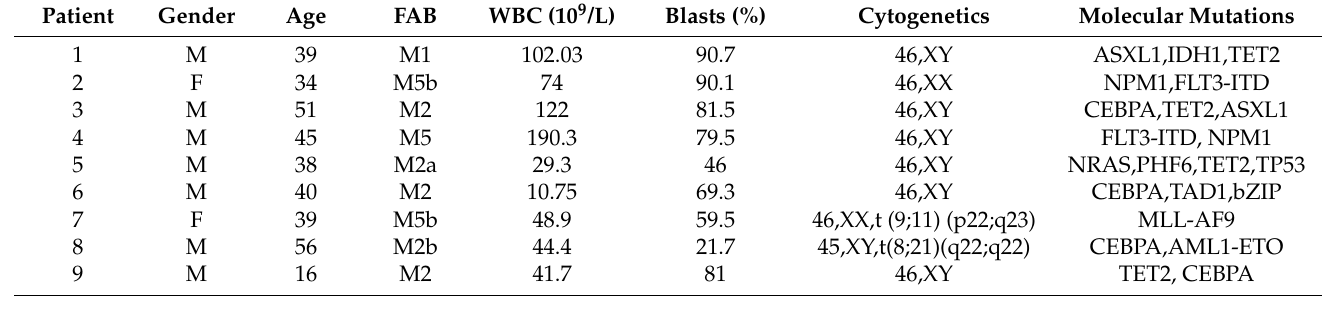
the indicated concentrations of anlotinib for 6 h. * p < 0.05, ** p < 0.01. Table 1. Clinical characteristics of AML patients.